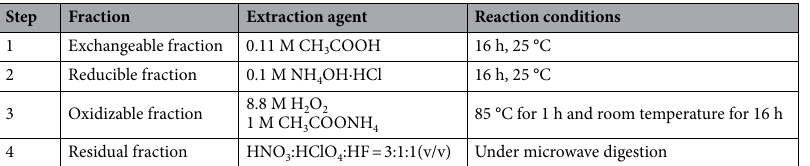
Table 1. BCR sequential extraction process for Ni of soil